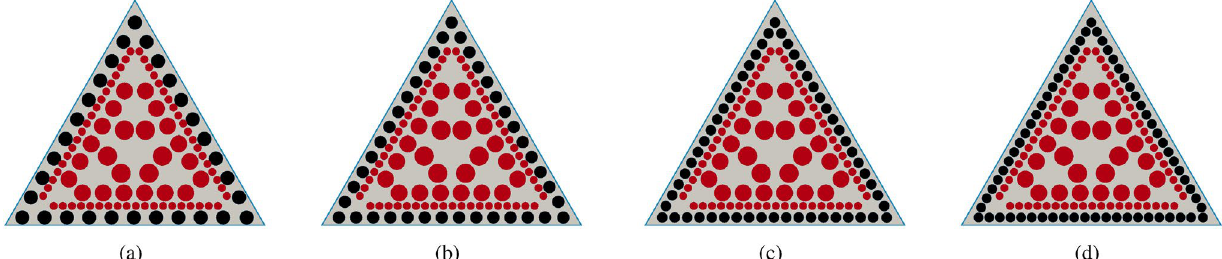
Figure 3. Reinforcement by fibre strands. From ( a ) to ( d ), the number of reinforcing (sclerenchyma) fibre strands increases whereas their total cross-sectional area remains constant. If the number is too high, single fibre strands become connected ( d ), thereby changing the torsional rigidity drastically and, thus, the procedure is stopped before this occurs. Colour code: epidermis (non-lignified): blue, parenchyma: grey, sclerenchyma fibres: black, vascular bundles: